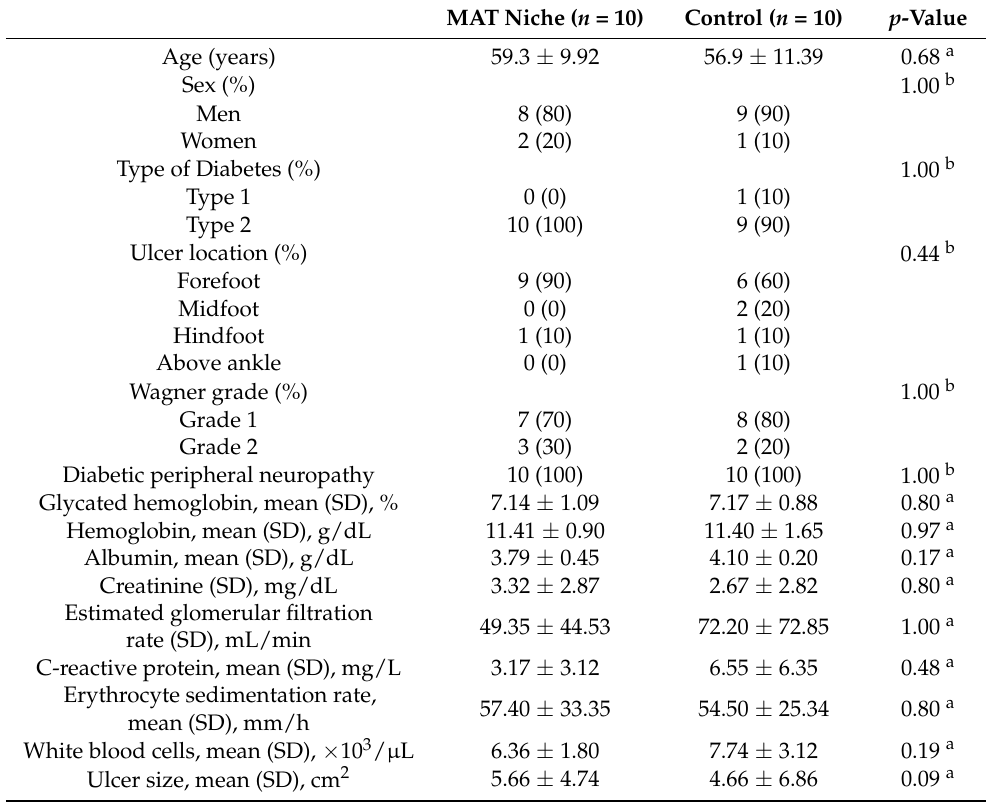
Table 1. Patient characteristics in the micronized adipose tissue (MAT) niche treatment and con- trol